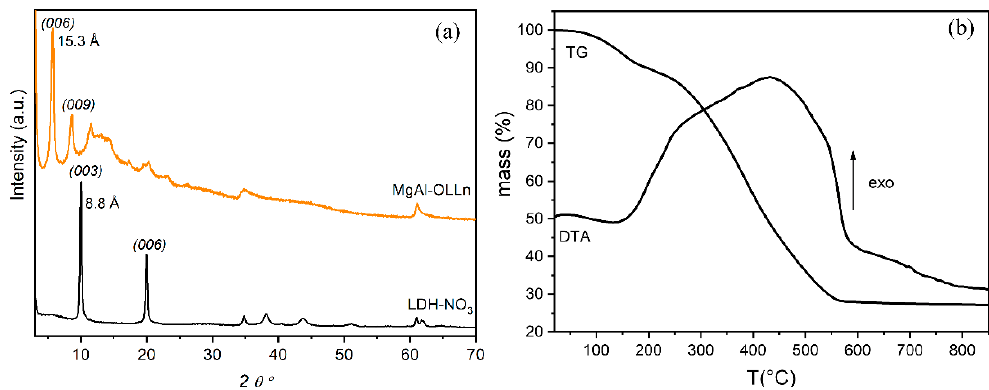
Figure 3. XRPD ( a ); TGA and DTA, operative conditions: air, 10 °C/min ( b ) of